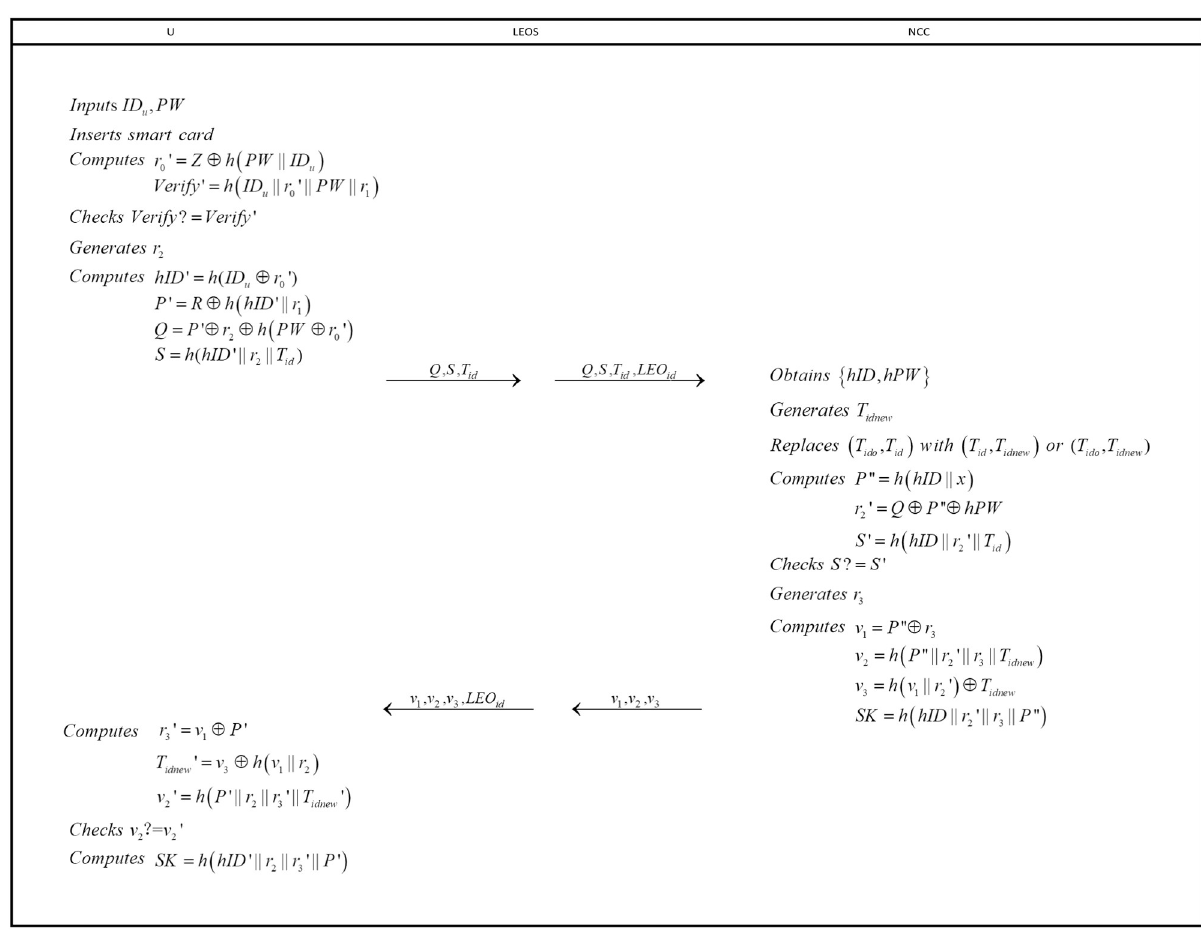
Fig 3. Login and authentication